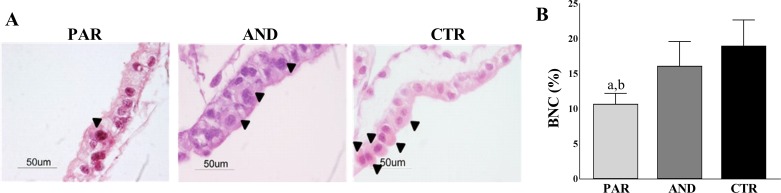
Reduced number of Trophoblastic Binucleate Cells (BNC) in PAR placentae (trophoectodermal epithelium) at day 20 of pregnancy.A) Hematoxylin & Eosin staining shows a reduced number of BNC (arrowheads) in the PAR trophoectodermal epithelium compared to AND and CTR. Note that BNC are organized in small clusters in AND and CTR but not in PAR tissues. B) The graph shows the reduced number of BNC in the PAR trophoectodermal epithelium compared to AND and CTR (a indicates P = 0.0248, b indicates P = 0.0009).